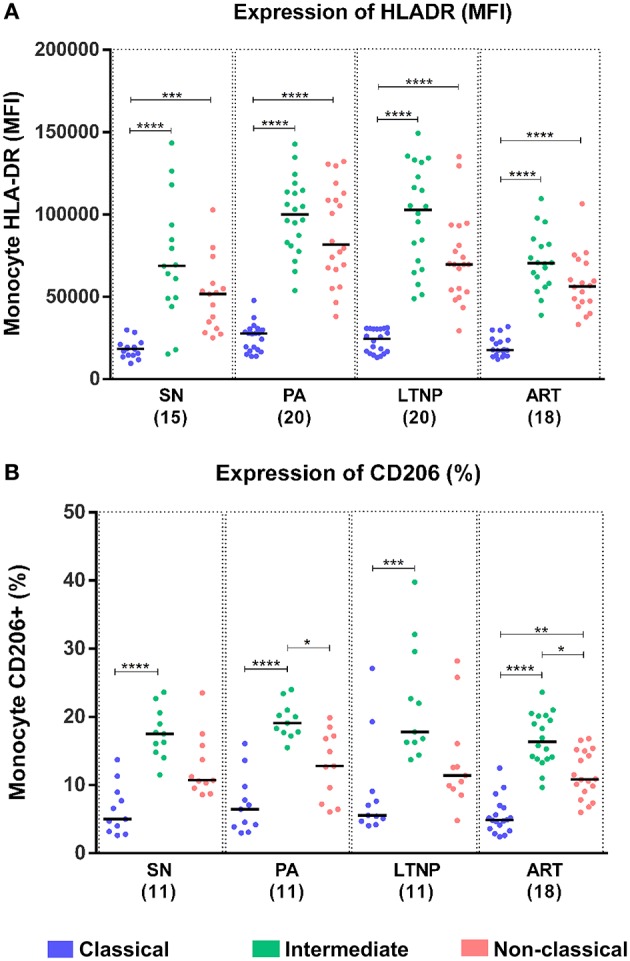
Differential expression of activation markers on monocytes subsets. (A,B) Expression of monocyte activation marker—HLA-DR (MFI) and marker for M2 phenotype—CD206 (%), respectively across monocyte subsets for each cohort. Kruskal-Wallis ANOVA followed by Dunn's multiple comparison test was used to assess significance; *P < 0.05; **P < 0.01; ***P < 0.001; ****P < 0.0001.